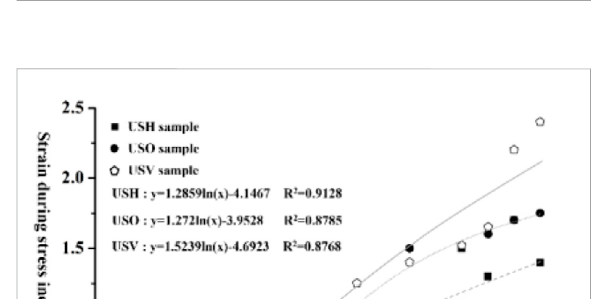
FIGURE 10 Duration-constant stress curve during load increasing